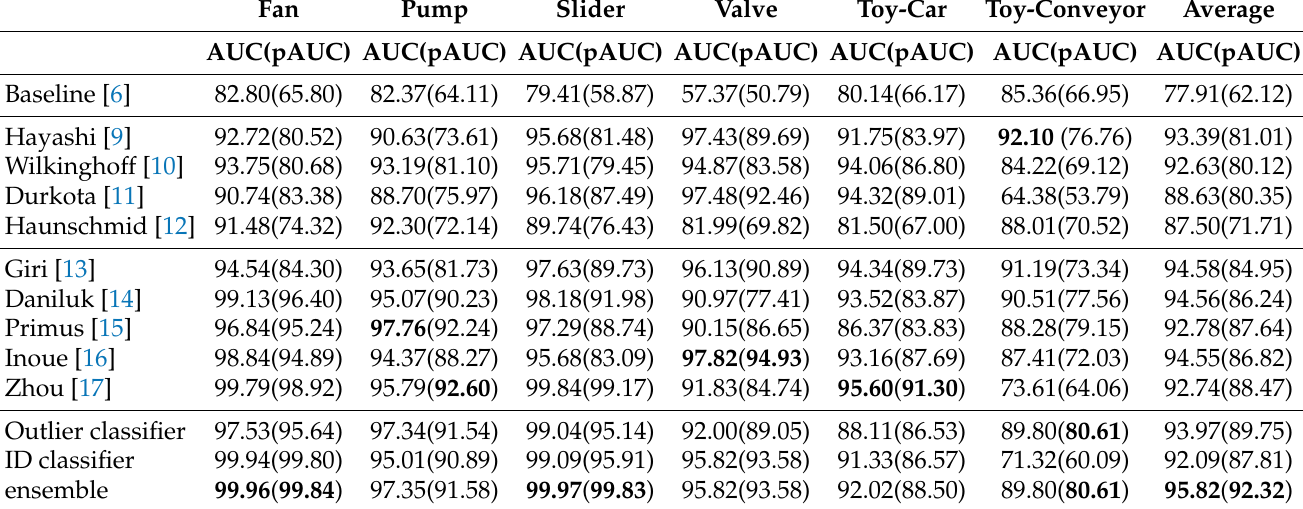
Table 2. AUC (%) and pAUC (%) for each machine